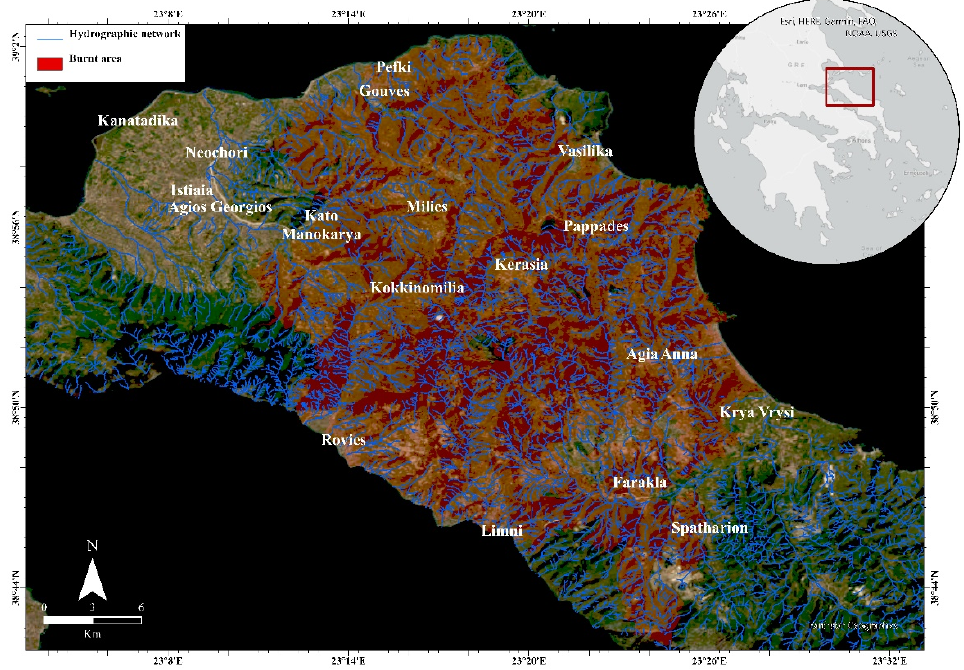
Figure 5. Areas affected in the wider area of northern Euboea Island. The map is available in web map view through the URL https://arcg.is/1CGbqz .(accessed on 15 May 2022)